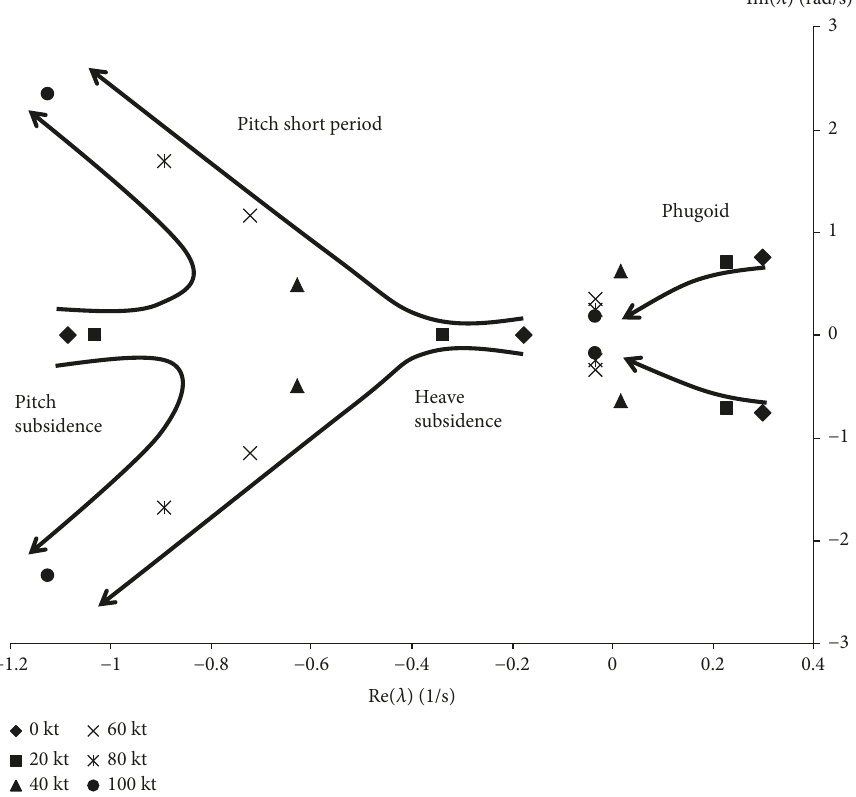
Figure 16: Longitudinal eigenvalue movement in helicopter